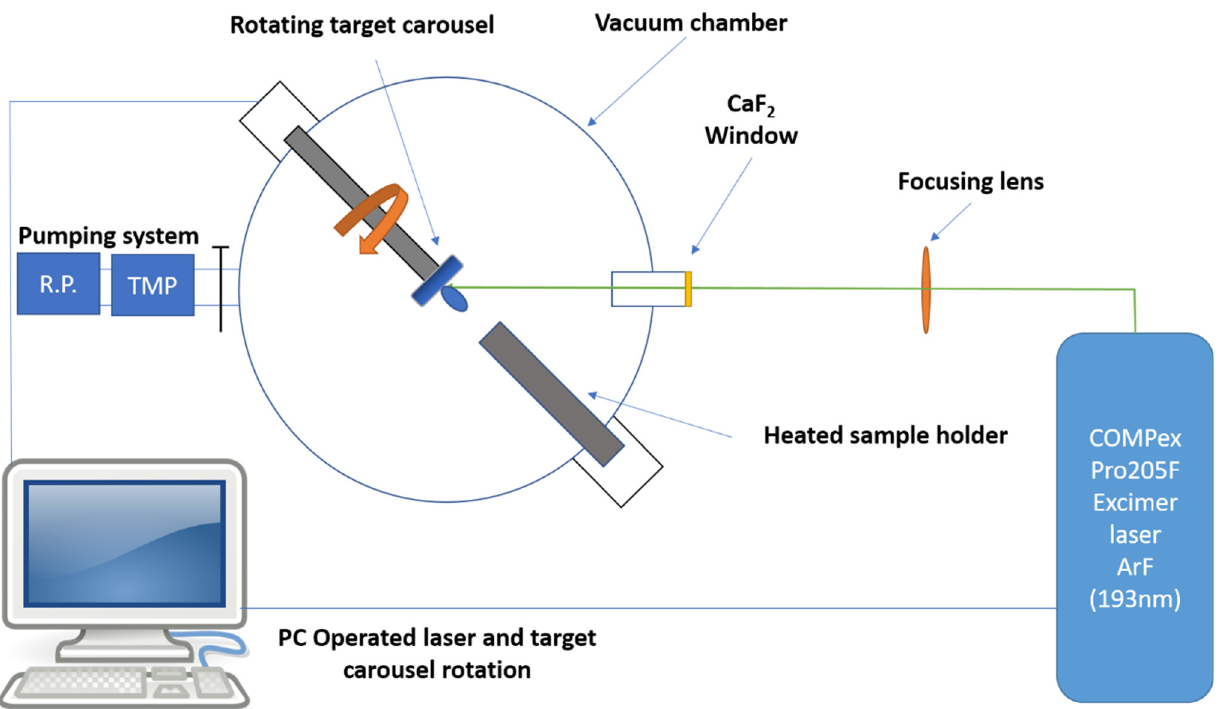
Figure 1. Schematic representation of the automated pulsed laser deposition system.